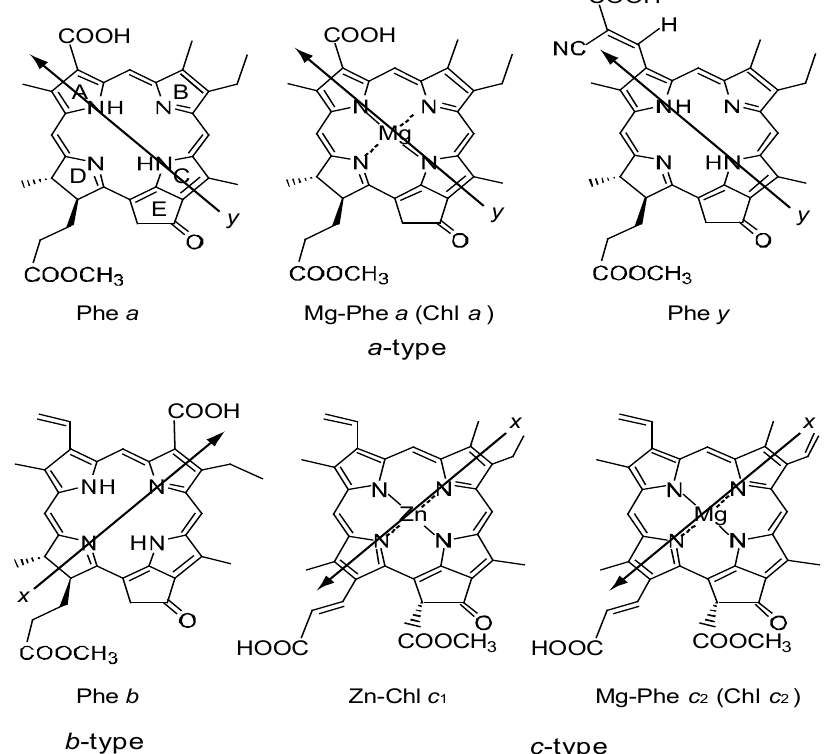
Figure 23. Chemical structures of Phe sensitizers without and with metal, Mg or Zn (reprinted from [7] with permission of MDPI Publishing).